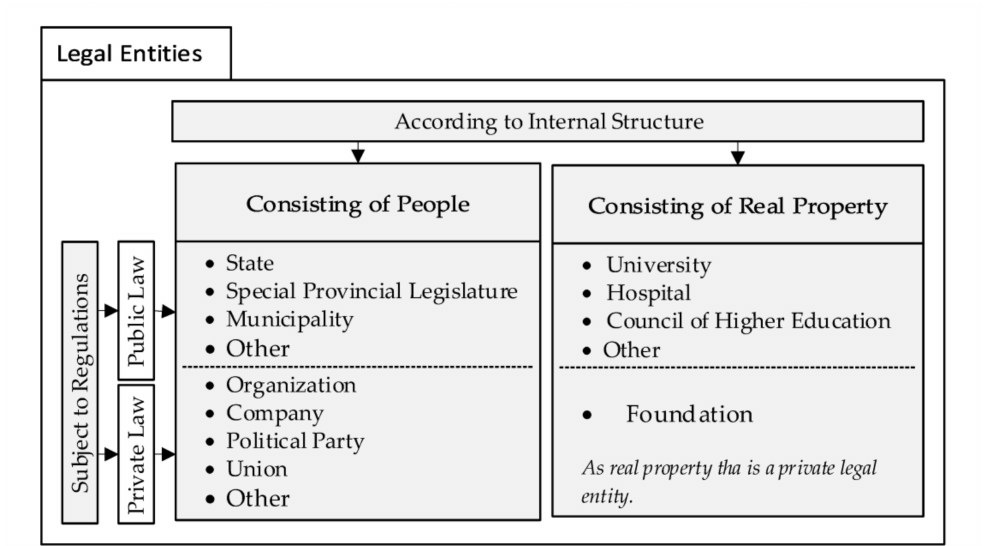
Figure 4. Legal entity of foundations (Adapted from